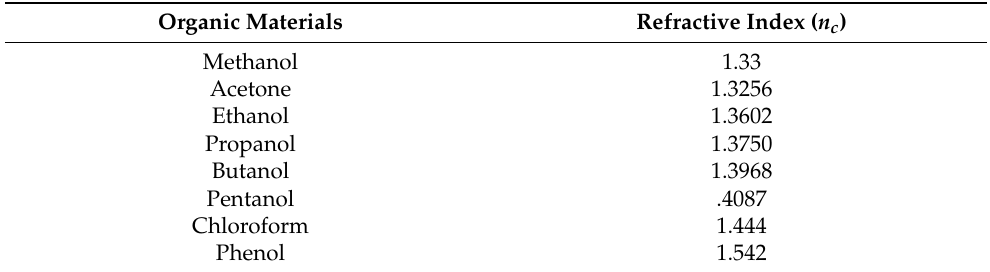
Figure 3. The transmittance spectra of the proposed bio-alcohol sensor with a cavity thickness d c = 125 nm at normal incidence when the cavity is loaded separately with water samples contain- ing the organic materials ( a ) methanol, acetone, ethanol and propanol and ( b ) butanol, pentanol, chloroform and phenol of a concentration of 30% with respect to the pure water sample. Table 2. The refractive index of different water samples containing organic materials, each of a concentration of